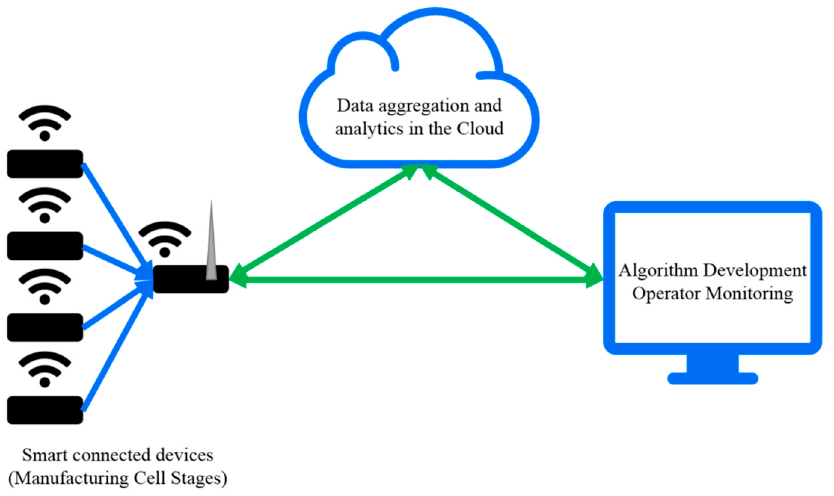
Figure 1. Interconnection between the industrial cell, the operator monitoring and the cloud.